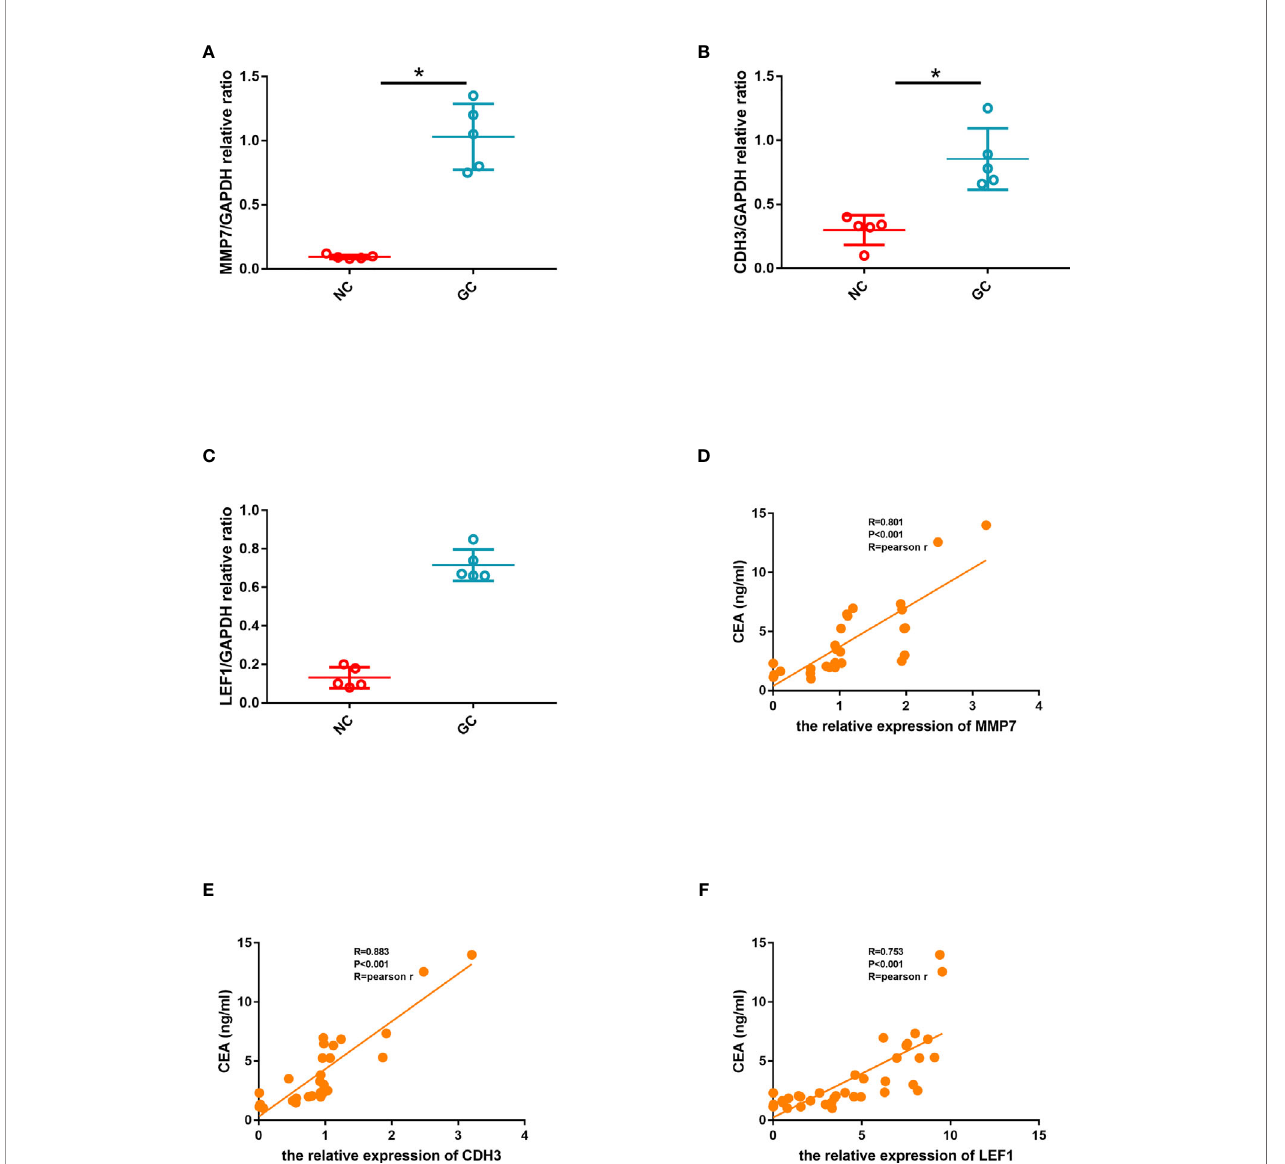
FIGURE 13 | (A) Quantitative comparison of MMP7 expression between the two groups. (B) Quantitative comparison of CDH3 expression between the two groups. (C) Quantitative comparison of LEF1 expression between the two groups. (D) The linear correlation between CEA and the relative expression of MMP7. (E) The linear correlation between CEA and the relative expression of CDH3. (F) The linear correlation between CEA and the relative expression of LEF1.